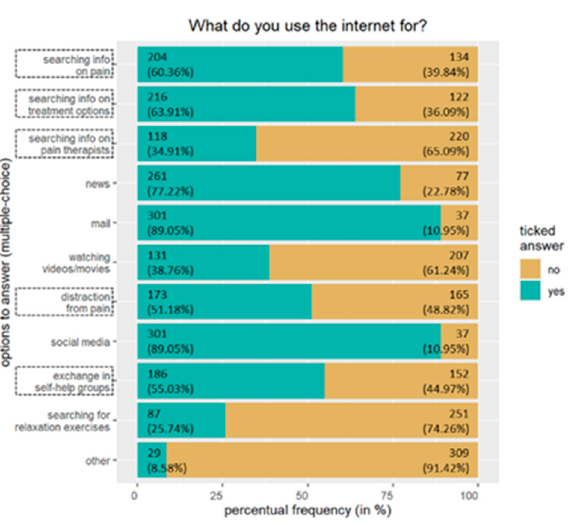
Figure A1. n = 338. The bars show absolute frequency (percentual frequency). Shown above are the participants’ responses regarding the thematic aim of their internet usage. Pain-related content is highlighted with a dashed box.